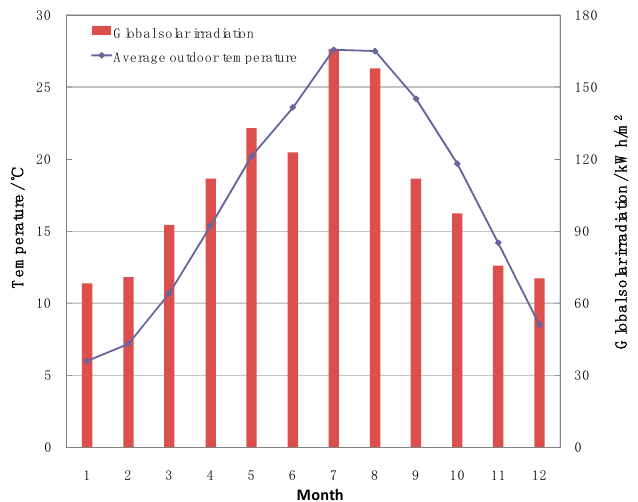
Figure 1. The monthly average outdoor temperature and global solar irradiation in Ningbo in 2018.